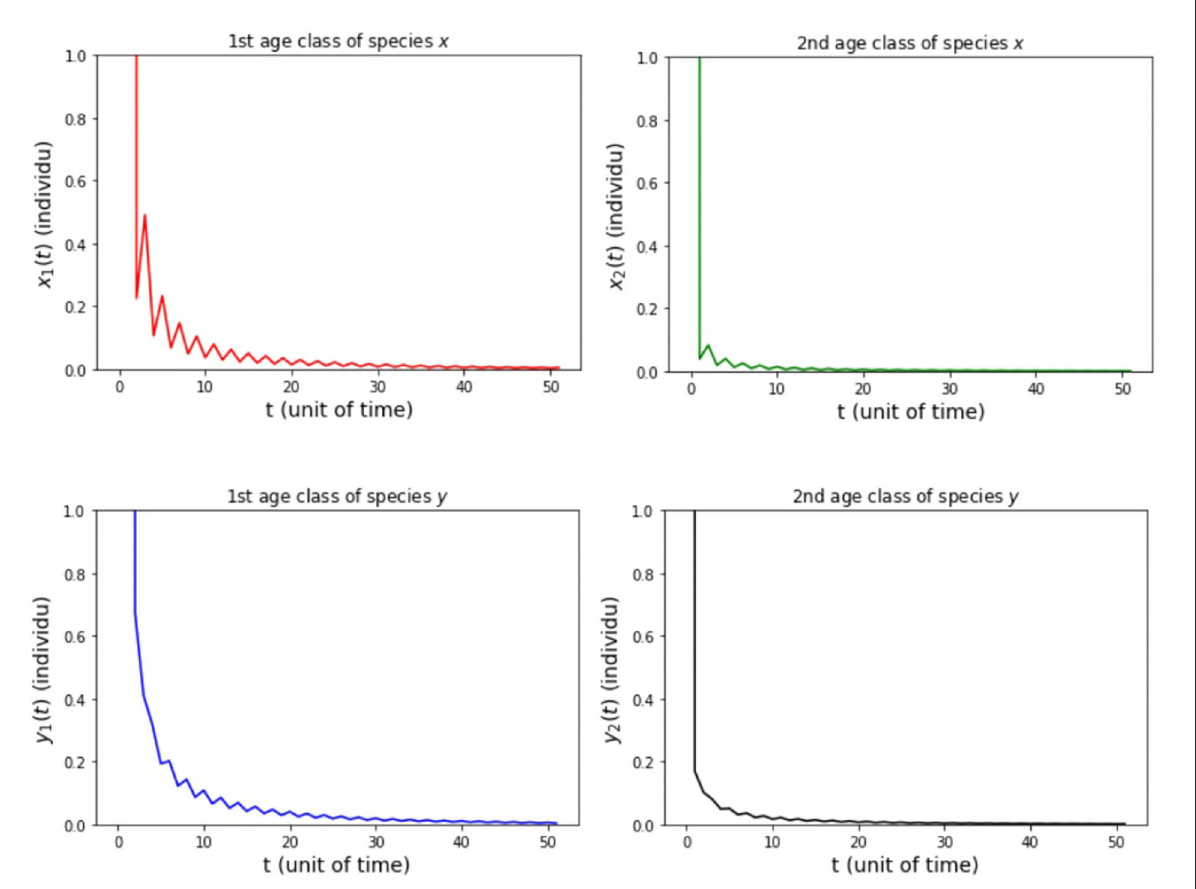
FIGURE2 Population growth of each age class from case (i) Model